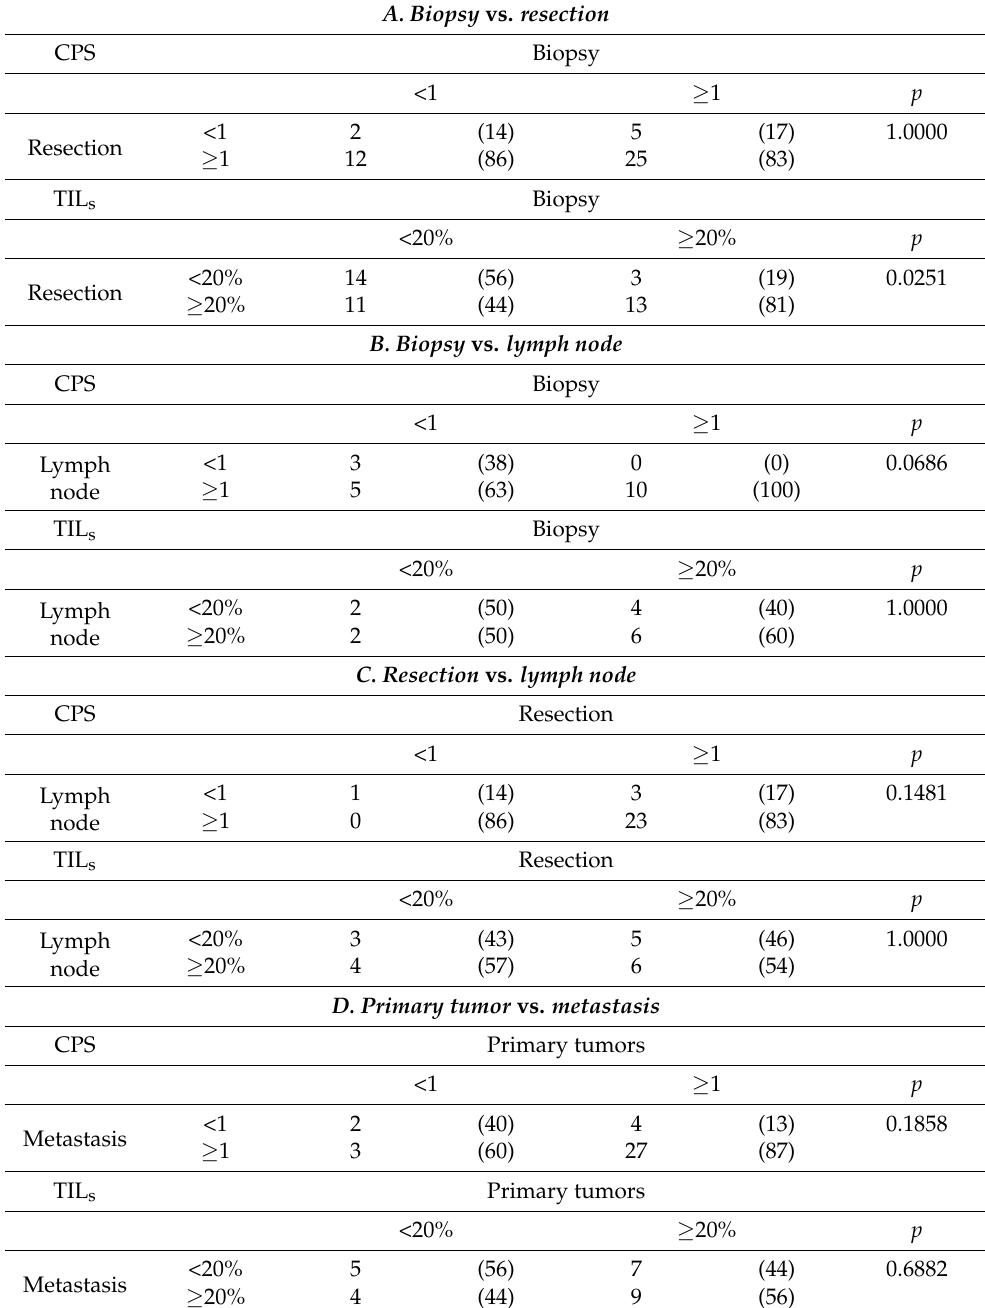
Table 3. Association for dichotomous CPS and TILs between paired tissue